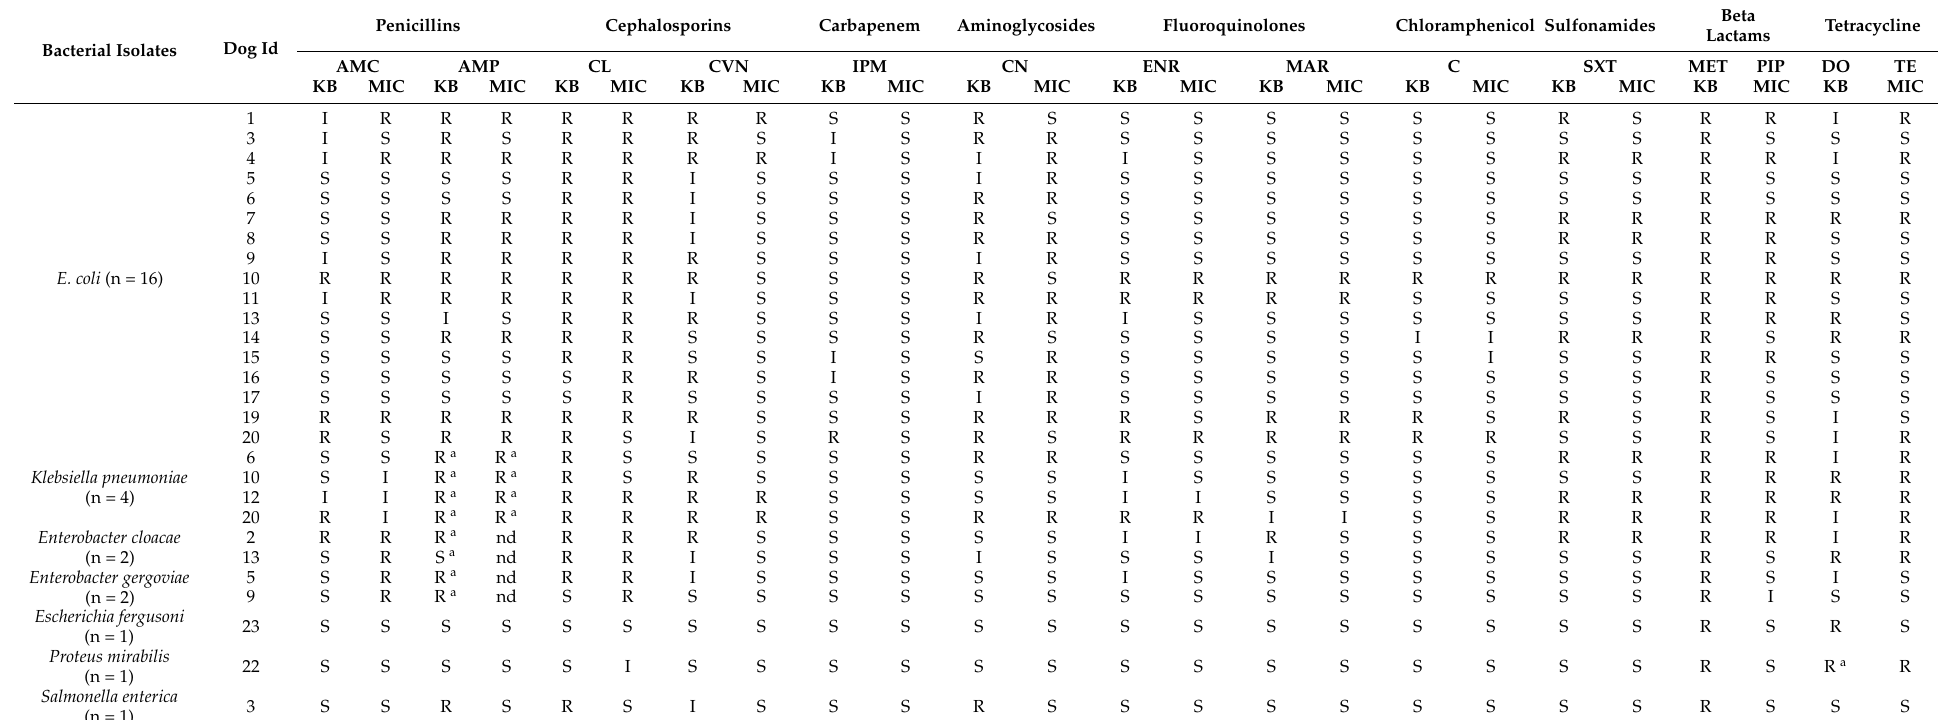
Table 5. Multidrug-resistance evaluation of 27 strains of the Enterobacteriaceae